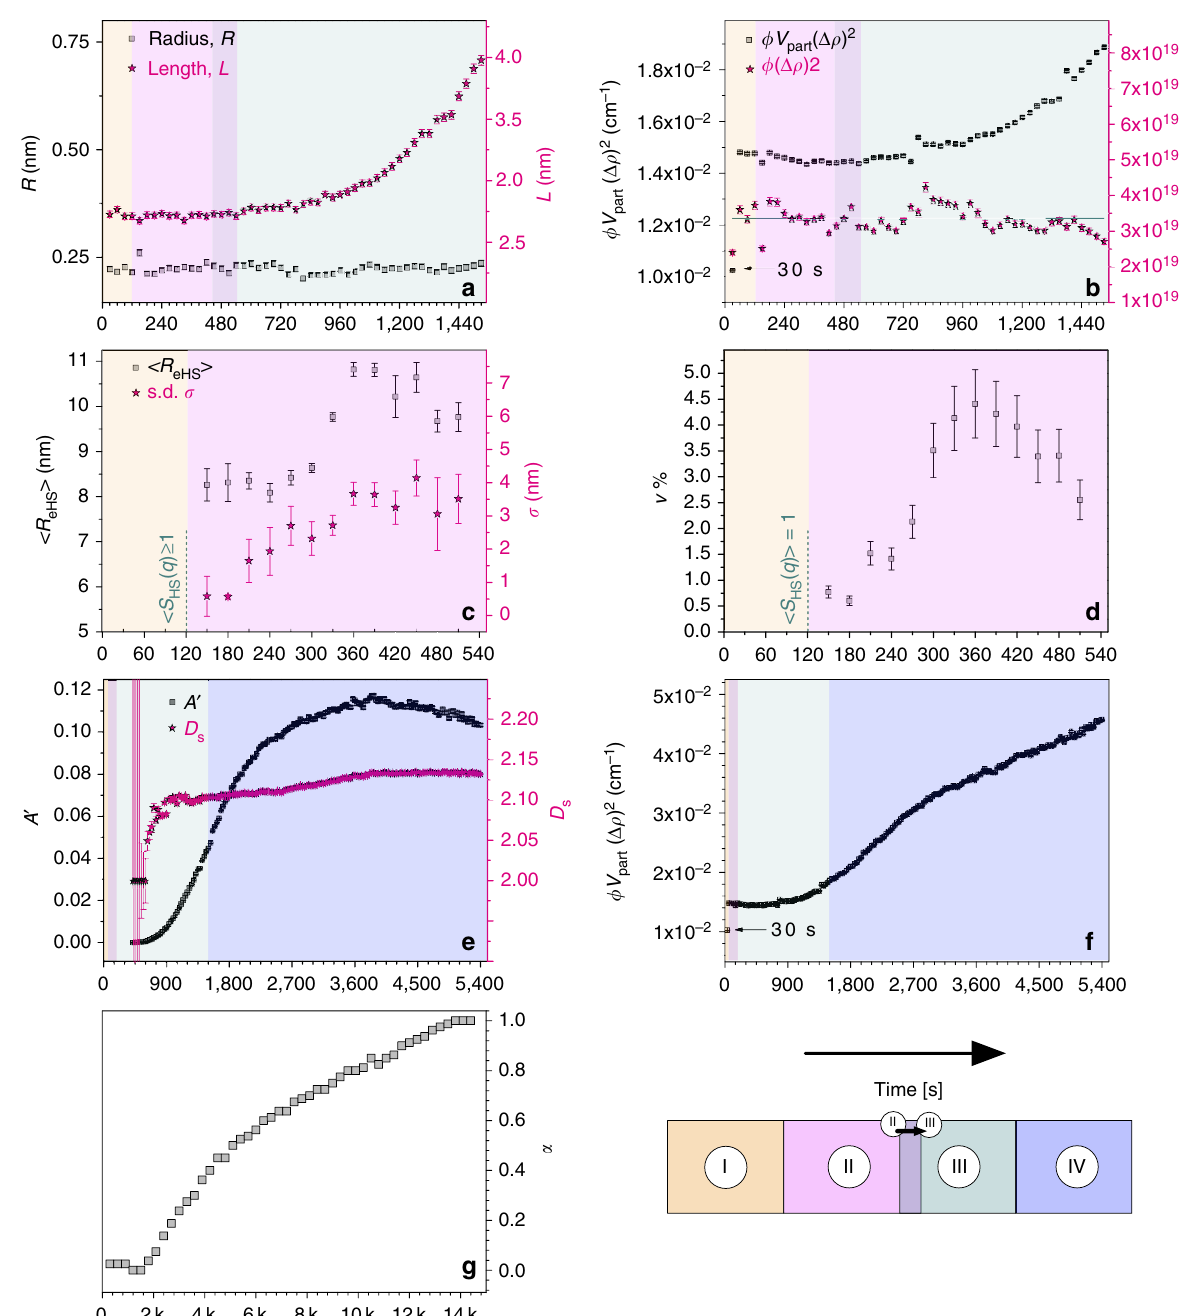
Figure 3 | Evolution of the fitting parameters as a function of time. ( a ) Elongated scatterers with lengths, L , and cross-sectional radii, R , up to B 1,500s; ( b ) pre-factors f V part ( D r ) 2 and f ( D r ) 2 up to B 1,500s; the average of the f ( D r ) 2 product is marked with a horizontal solid line; ( c ) mean effective hard-sphere radii o R eHS 4 and their s.d.’s, s characterizing o S HS ( q ) 4 ; ( d ) local volume fractions, v , characterizing o S HS ( q ) 4 ; ( e ) surface area contribution, A 0 , and surface fractal dimension, D s , characterizing o S SF ( q ) 4 . Note that up to 600s the A 0 and D s values exhibited very large uncertainty, due to the limited contribution of large scatterers in the low- q range of the scattering patterns. For D s ( o 600s) any value between 2 and o 3 would produce reasonable fits, but the yielded A 0 values for all D s 4 2 were significantly out of trend and are thus not shown; ( f ) pre-factor f V part ( D r ) 2 evolution up to 5,400s; ( g ) Degree of crystallization a versus time from the corresponding WAXS measurements derived from the change in the area of the (020) WAXS reflection of gypsum measured simultaneously with the corresponding SAXS patterns. The background colours in a – f indicate stages I–IV, according to the legend. Time scales are in seconds (horizontal axes) except for g where they are in thousands of seconds.